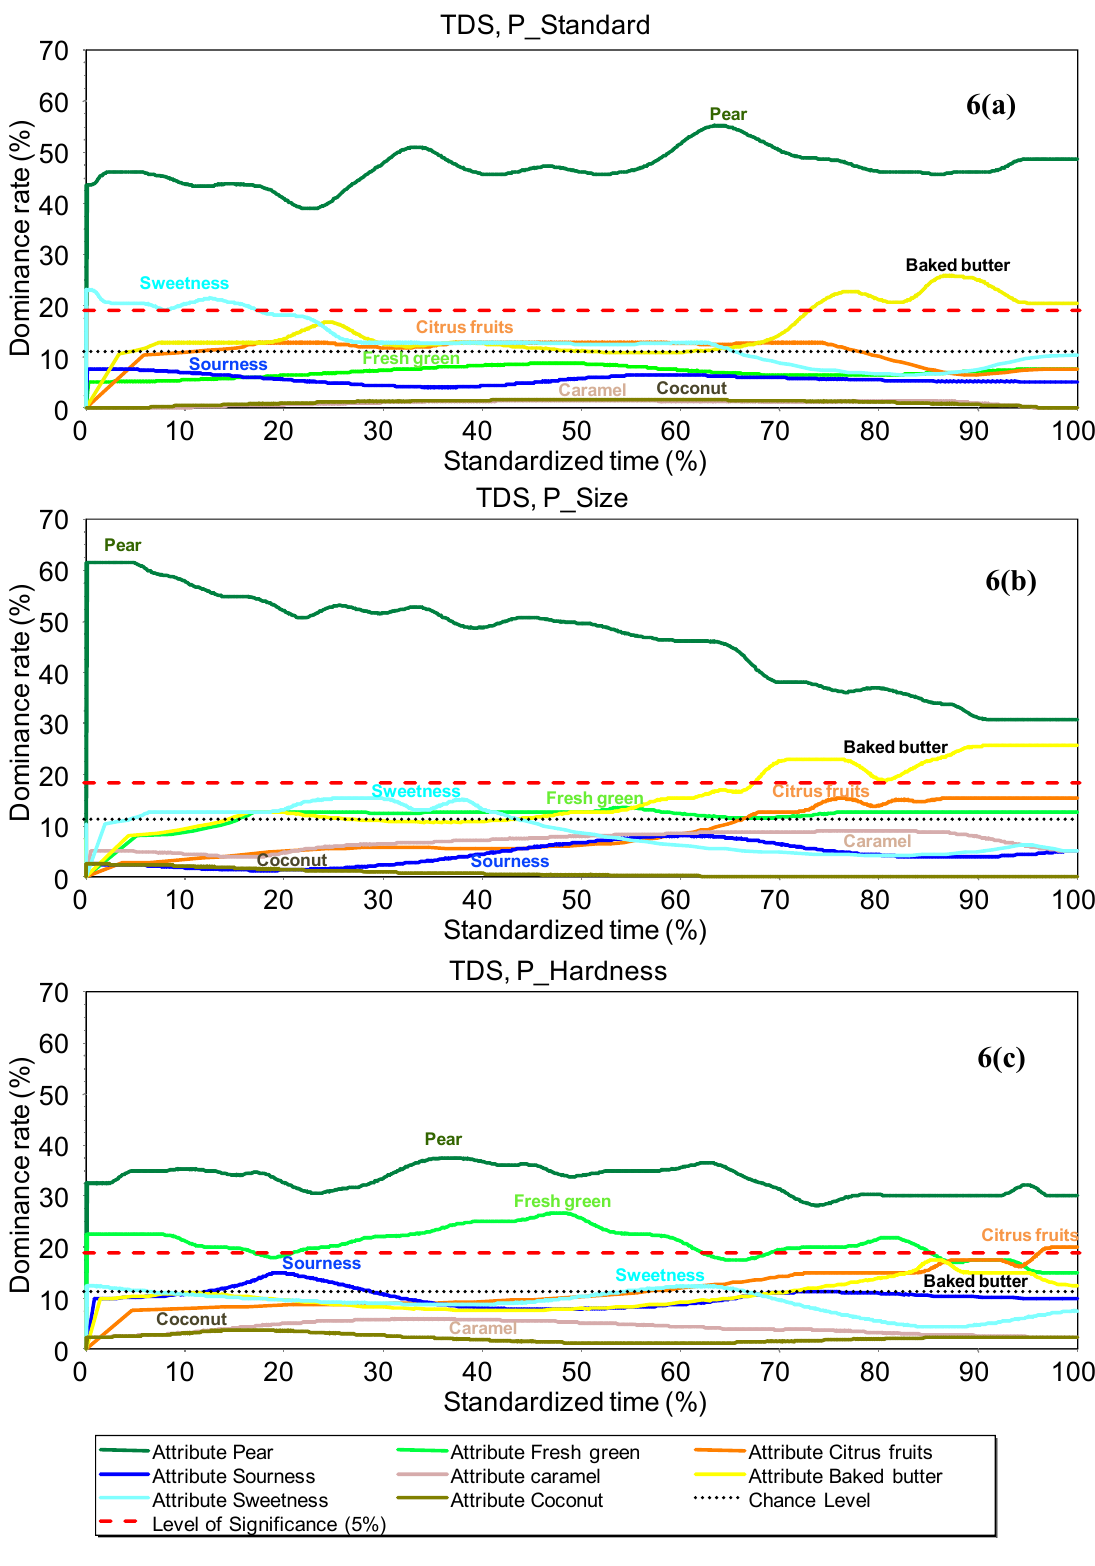
Figure 6. TDS curves: dominance rate (%) over standardized times for the three yogurts. ( a ) P_Standard yogurt; ( b ) P_Size yogurt; ( c ) P_Hardness yogurt. The chance level and the significance level are indicated on each graph. Attributes are considered to be significantly dominant by the panel when they are situated above the significance